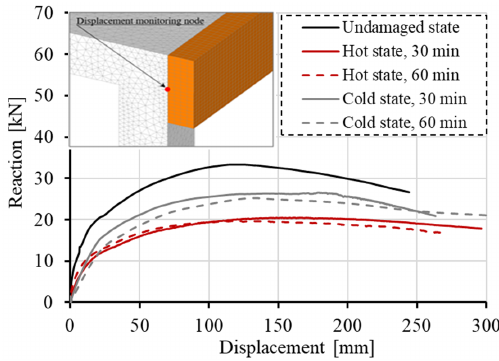
Figure 12. Static analysis—reaction-displacement curves.